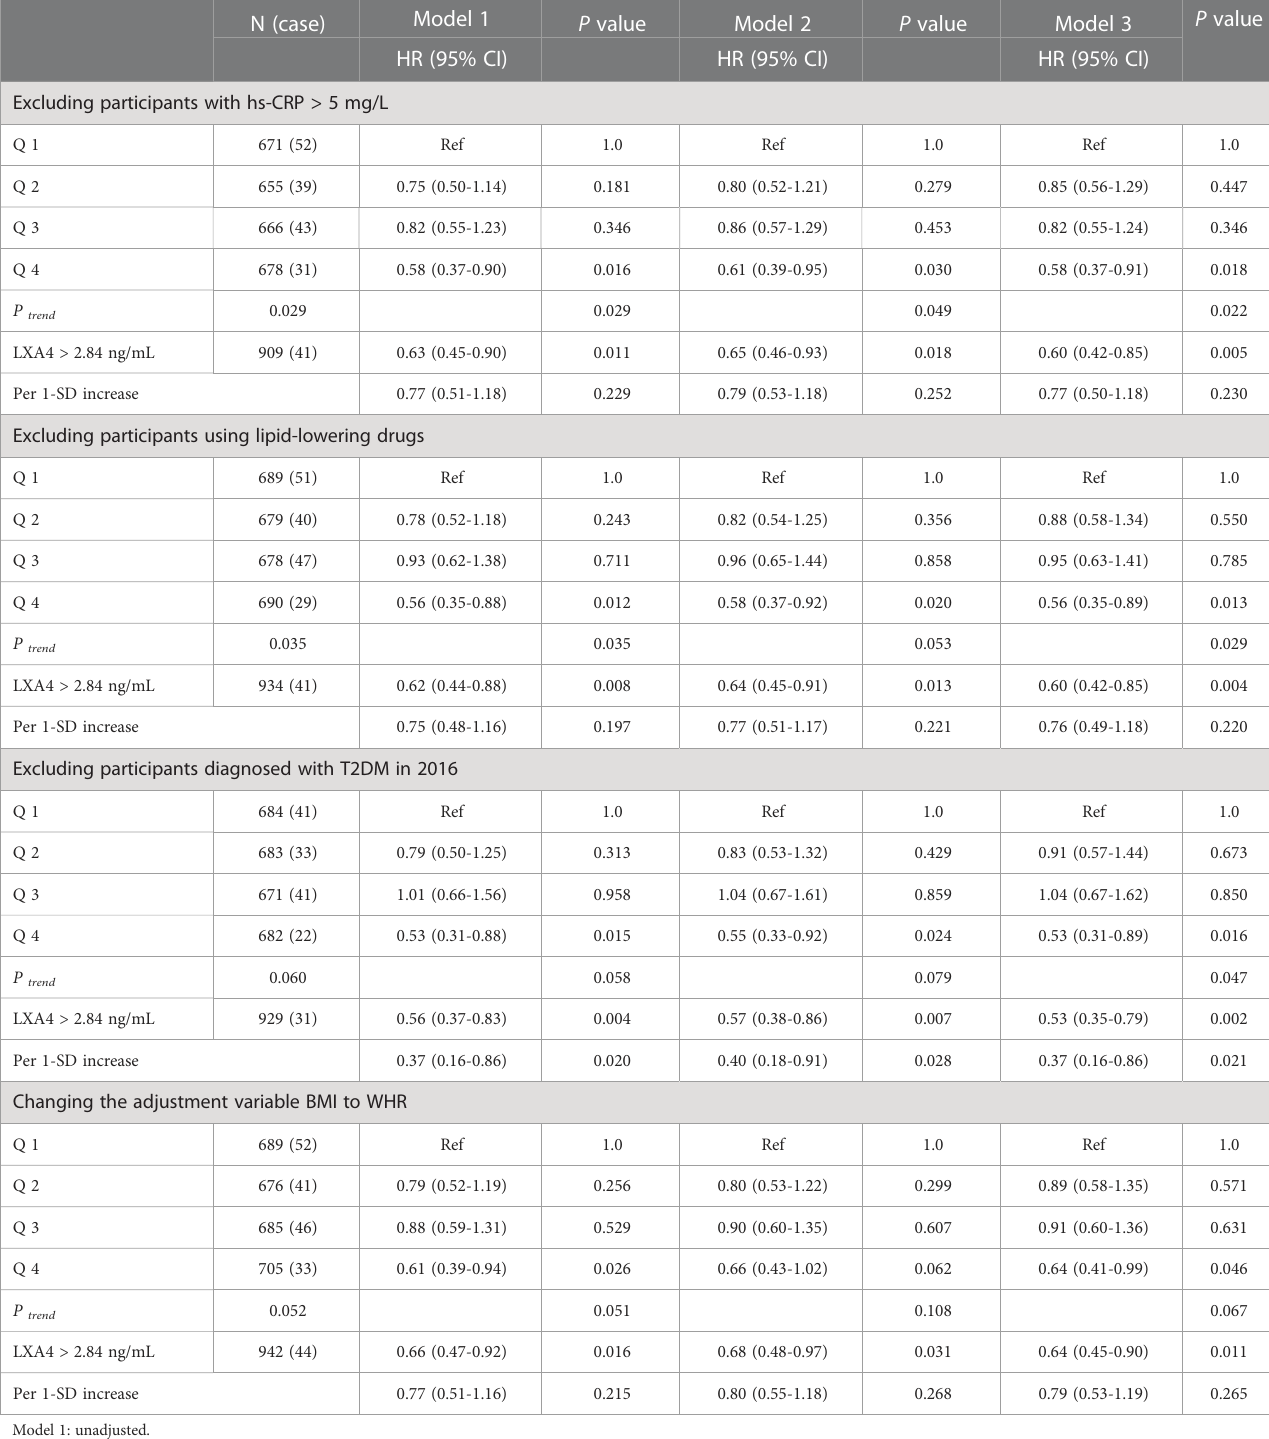
TABLE 3 Sensitivity analysis of the association between LXA4 and the incidence of